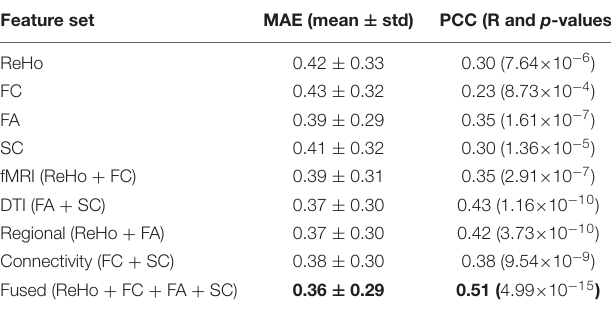
TABLE 1 | Prediction performance of different models using different feature sets.